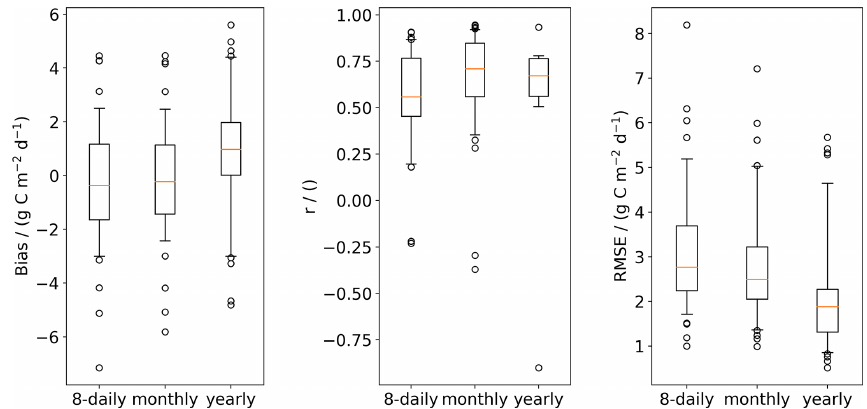
Figure 5. Site-based cross-validation for 8d, monthly, and yearly sampling of GPP from VODCA2GPP and FLUXNET. RMSE, bias, and Pearson’s r were computed at each of the 10% of FLUXNET sites that were omitted during the respective training run. Non-significant Pearson correlations ( p value < 0 . 1) were ignored. The boxplots for Pearson’s r are based on the 71 (8d), 66 (monthly), and 8 (yearly sampling) significant values for Pearson’s r values. The whiskers of the boxplots extend to the 5th and 95th